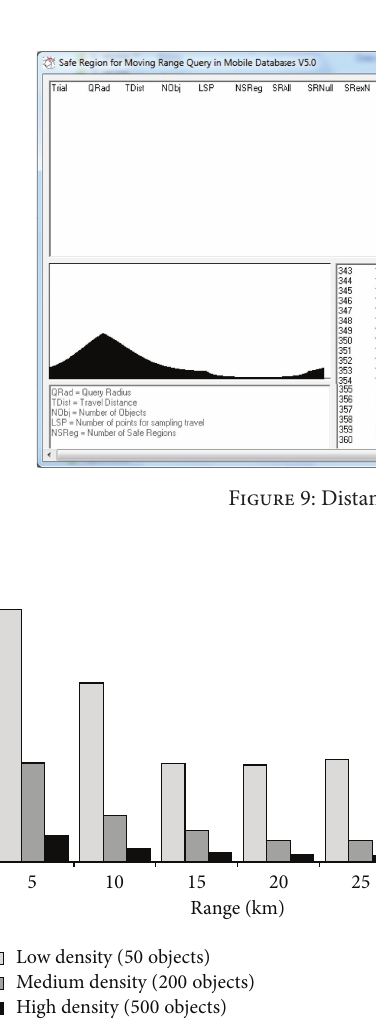
Figure 10: The average distance the query can move until its objects of interest changes in different density